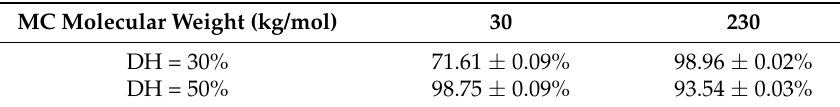
Table 3. Entrapment efficiencies of dexamethasone. n = 3, with error bars corresponding to the standard